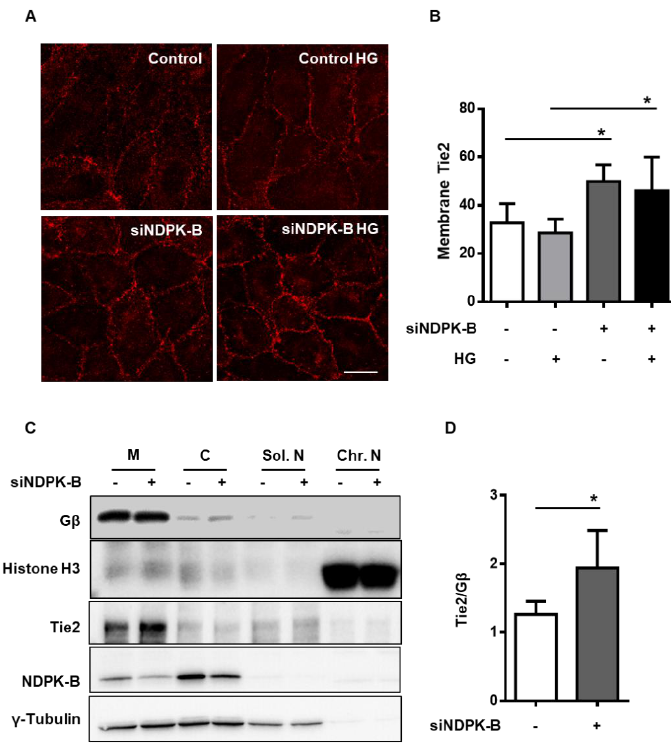
Figure 3. NDPK-B depletion enhances Tie2 content at the cell membrane. HUVECs were transfected with either scrambled control ( − ) or siRNA against NDPK-B (siNDPK-B, + ) and treated for 24 h without ( − ) or with HG ( + ) if indicated. ( A ) Representative immunofluorescence images of Tie2 expression in NDPK-B depleted ECs with or without HG treatment. ( B ) Quantification of membrane Tie2 as pixel density in ( A ). ( C ) Membrane (M), Cytosolic (C), soluble nuclear (Sol. N), and chromatin nuclear (Chr. N) fractions were prepared from control and NDPK-B depleted cells. Representative immunoblots showing the subcellular localization of Tie2 in control and NDPK-B depleted ECs. ( D ) Tie2 was quantified relative to the membrane-anchored protein G β ( n = 4). * p < 0.05. Scale bar 20 µ